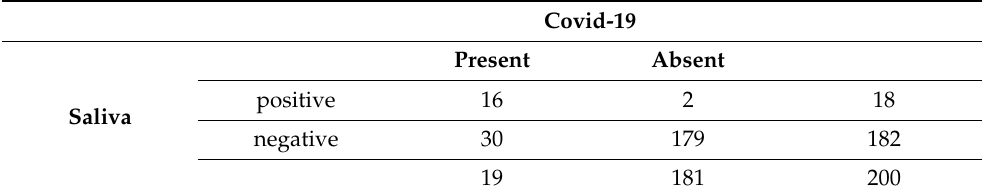
Table A2. Prevalence of COVID-19 equal to 9.5% with sensibility equal 84.2% and specificity equal 98.9%.